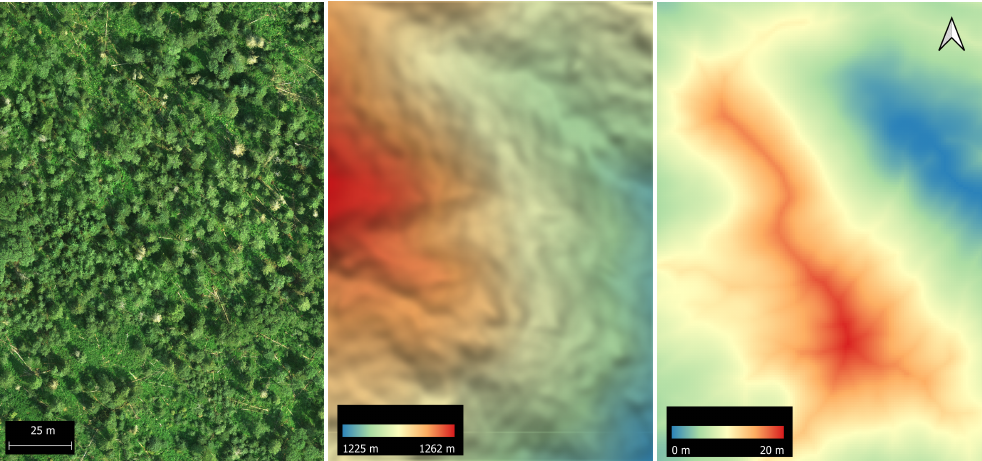
Figure 4. Orthophoto ( left ), digital surface model ( centre ) and depth-to-water map ( right ) from an aspen-dominated forest